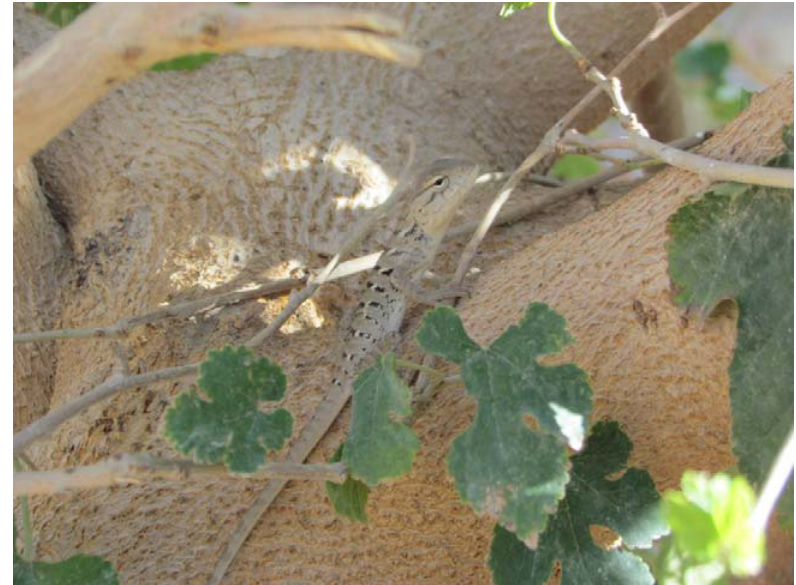
F IGURE 2 . Juvenile of Calotes versicolor in Gervani village on Mulberry ( Morus alba ), Sistan and Baluchestan province, Iran (Photo by: A.